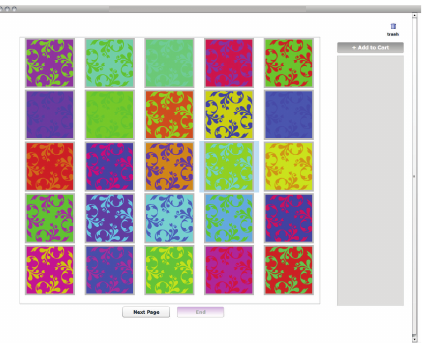
Figure 17: Interface used by participants during the experiment to rate